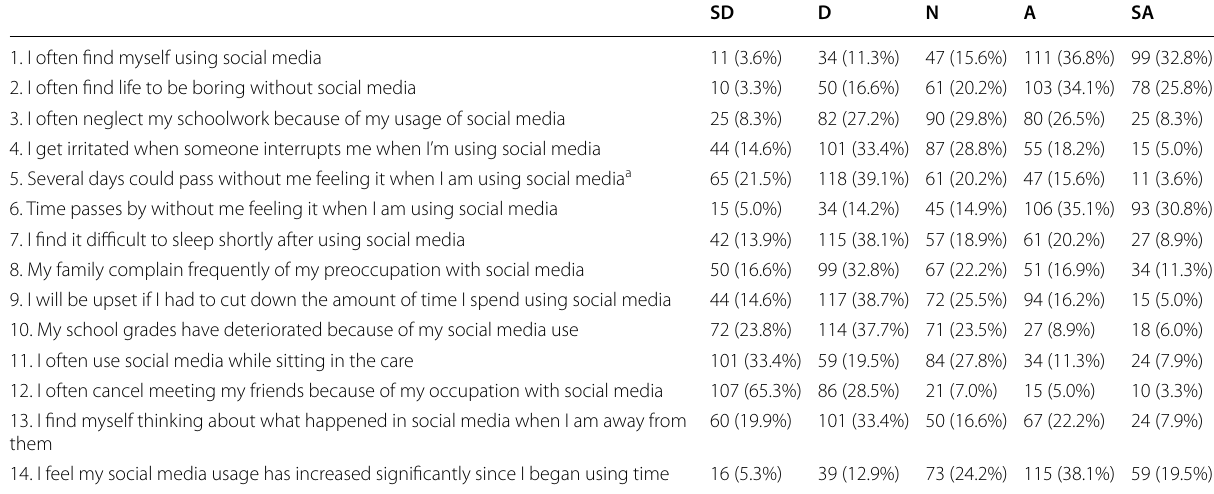
Table 3 Social Media Addiction Scale responses of the participants